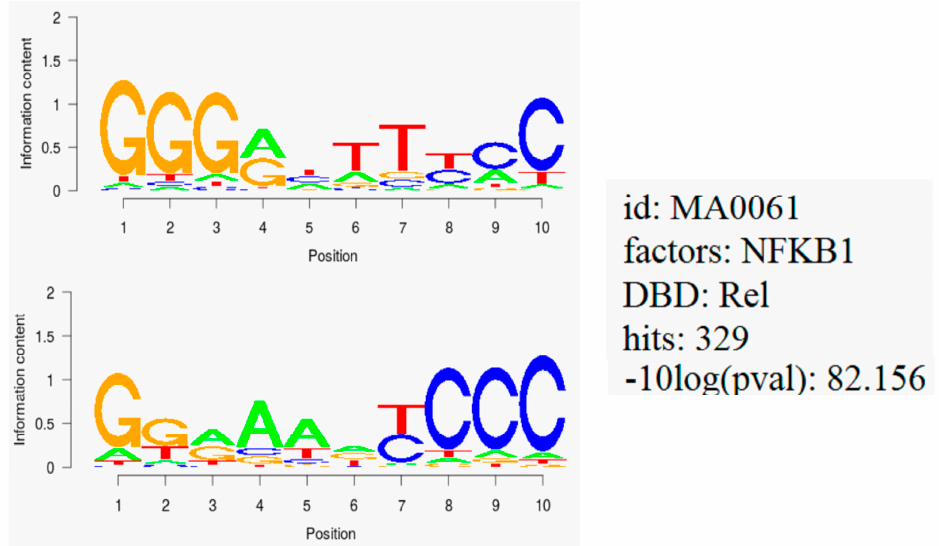
Figure 7. Motif analysis of 25 kb upstream regions of 40 genes identified by COMPARE analysis revealing the significant presence of NF- κ B binding motif.